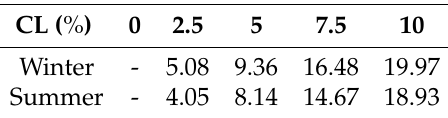
Figure 11. ∆ f for different percentages of controllable load, including the reference case. [ 5630,5635 ] Table 3. ∆ f min variation (%) for t ∈